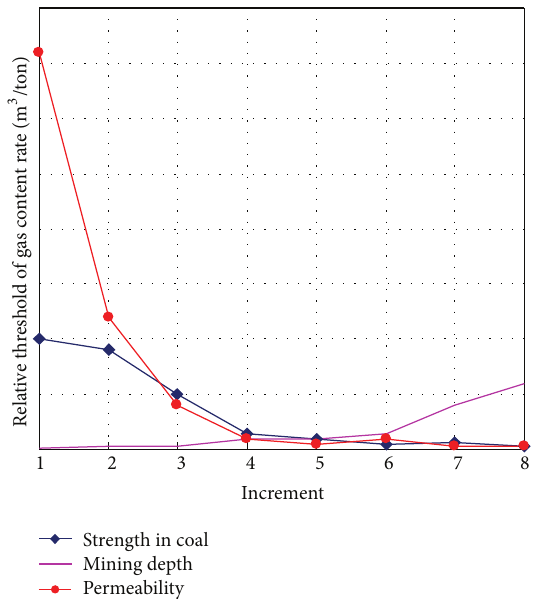
Figure 10: Major parameters versus relative threshold of gas content rate (permeability changed rate reduction faster than the changed rate of strength in coal while the mining depth changed rate increases as